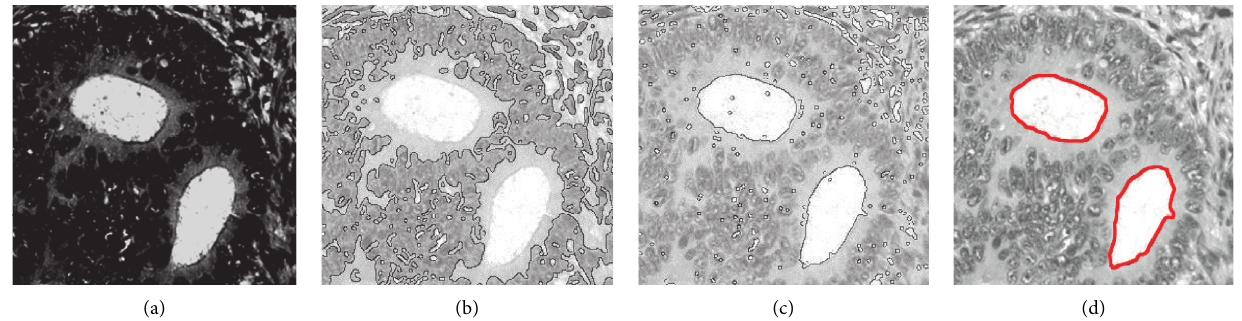
Figure 11: Segmentation of lumens based on the improved SPF approach. (a) Background stain intensity map. (b) Traditional SPF approach segmentation result, and it can be seen that the lumen cannot be accurately segmented. (c) Improved SPF approach segmentation result. (d) The small target has been removed.